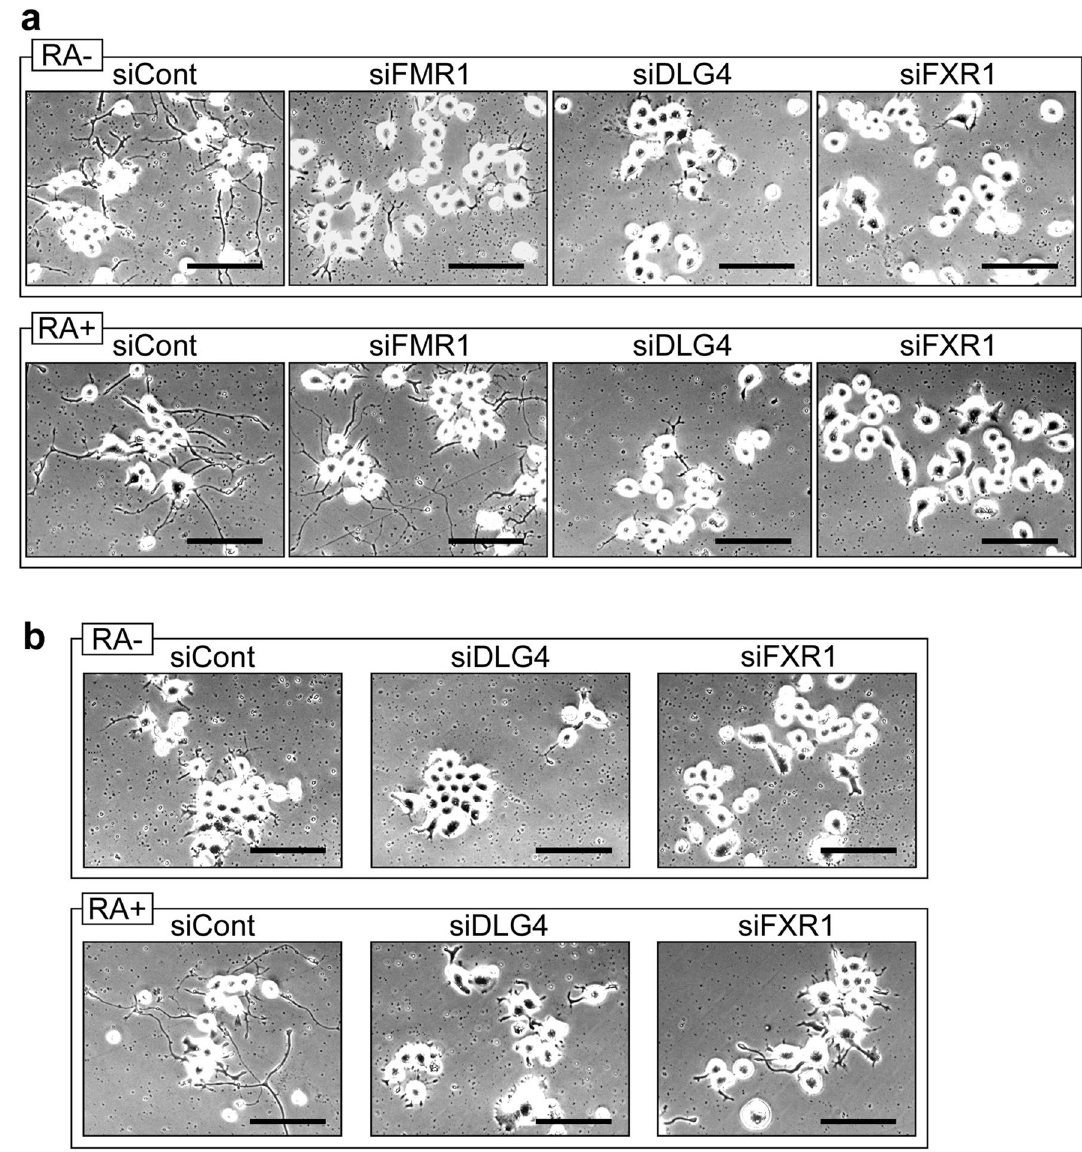
Figure 5. Process formation of N2a cell. ( a ) N2a cells with gene knockdown under differentiation conditions. N2a cells were transfected with the indicated siRNAs and incubated in serum-free differentiation medium with (RA +) or without (RA-) retinoic acid for 3 days. The cells were observed by a microscope. Scale bars indicate 100 μm. ( b ) Def.FMRP-N2a cells with gene knockdown under differentiation conditions. Def.FMRP-N2a cells were treated and observed as in ( a ). Scale bars indicate 100